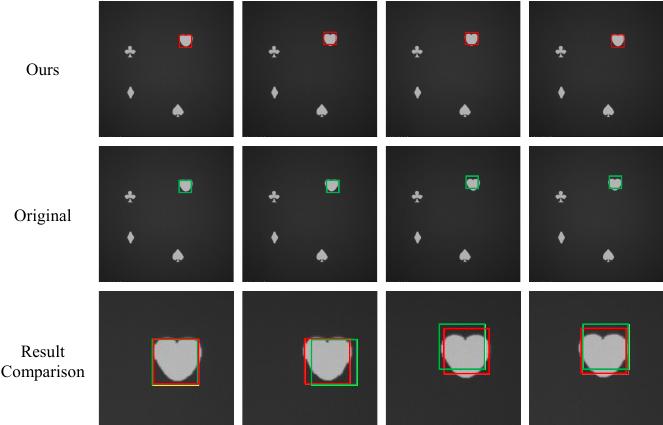
Figure 13. Detected location of an object retrieved from proposed and existing